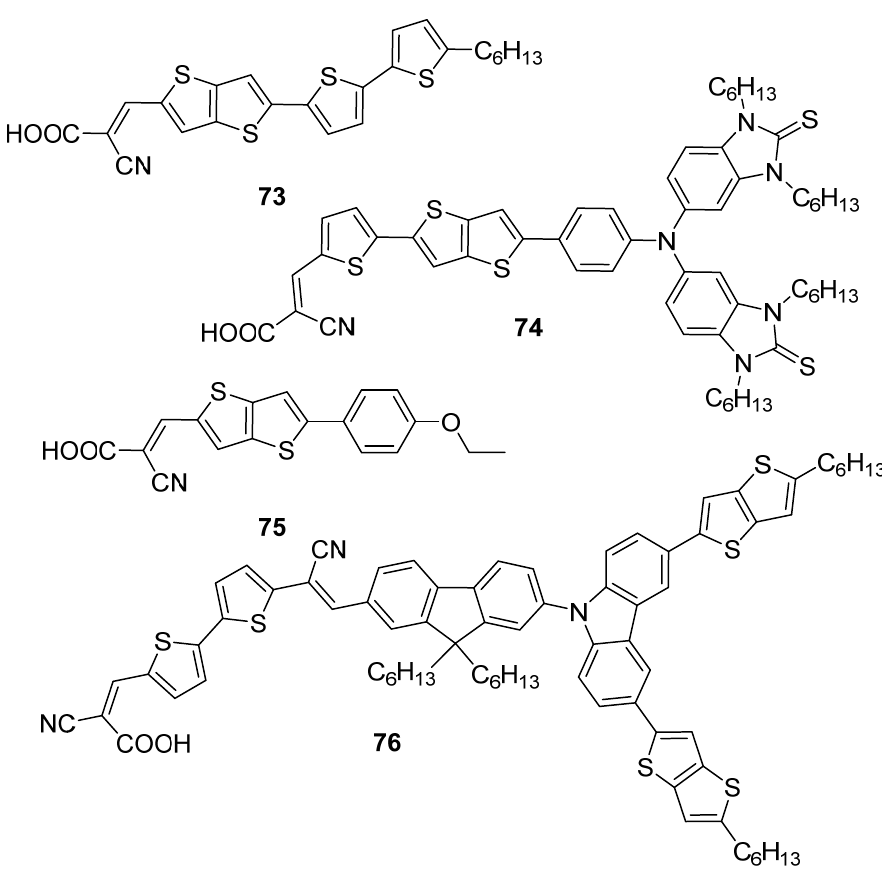
Figure 9. Push–pull thieno[3,2- b ]thiophene derivatives 73 – 76 for DSSCs. Table 6. Fundamental properties of dyes 73 – 76 .